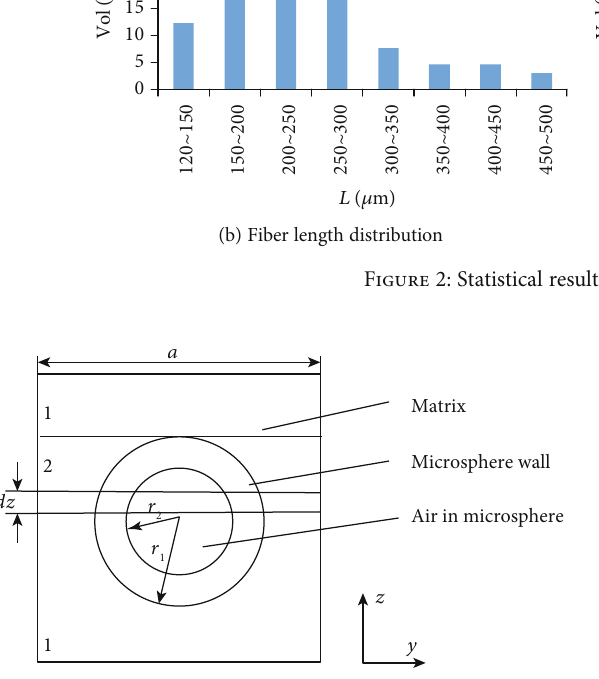
Figure 3: Microsphere unit cell